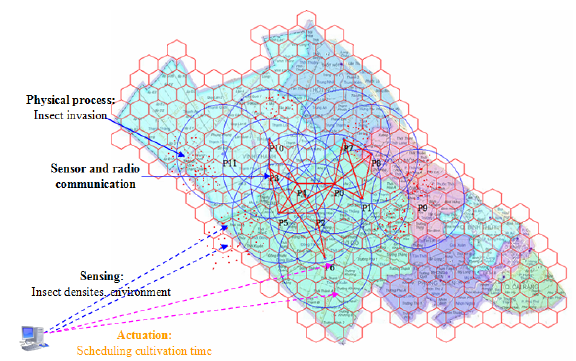
Figure 5. ABPH surveillancenetworkis composedof2 systems. A insect physical system is the insect’s workingspace whichis dividedas cells. These cells are monitoredby a WSN system.